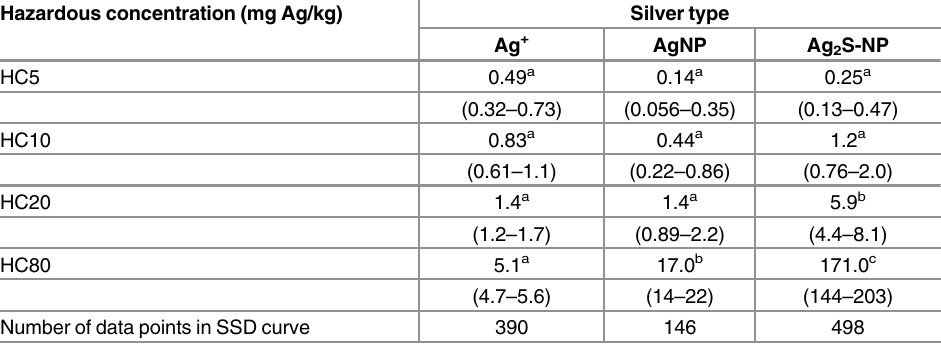
Table 2. Hazardous concentrations (HC) for ionic Ag (Ag + ), Ag nanoparticles (AgNP) and Ag sulfide nanoparticles (Ag 2 S-NP) at which 95%, 90% and 80% of soil OTUs are protected (HC5, HC10 and HC20, respectively). Upper and lower 95% confidence intervals are shown in parentheses. Hazardous con- centrations at which only 20% of soil OTUs are protected (HC80) were calculated to define the less sensitive OTUs. For a given HC, significant differences ( p < 0.05) between Ag treatments are indicated by different superscript